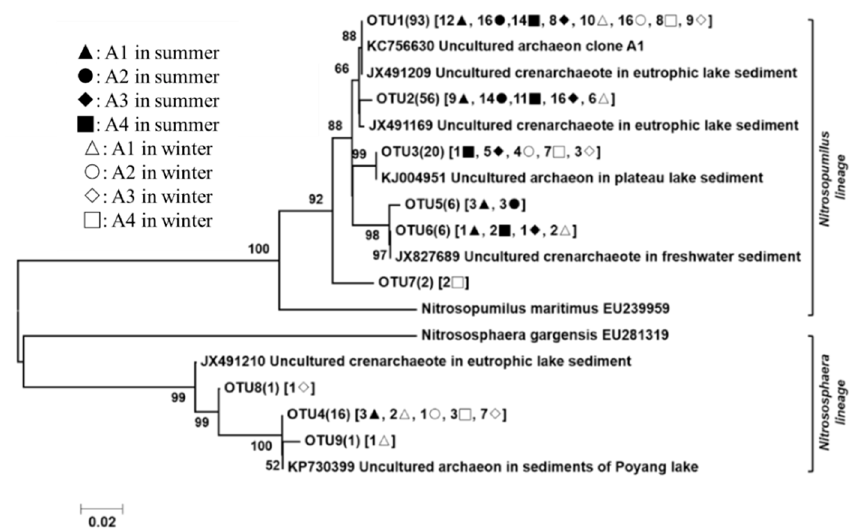
Figure 5. Neighbor-joining phylogenetic tree based on the nucleotide sequences of the Arch - amoA gene. The numbers at the nodes represented the credible values that were calculated from 1000-times bootstrap tests. Bootstrap values greater than 50% were shown. The scale bar indicated 0.02 substitutions per nucleotide position. GenBank accession numbers were shown for sequences from other studies. Numbers in parentheses following each OTU indicated the number of sequences recovered from each sampling site.